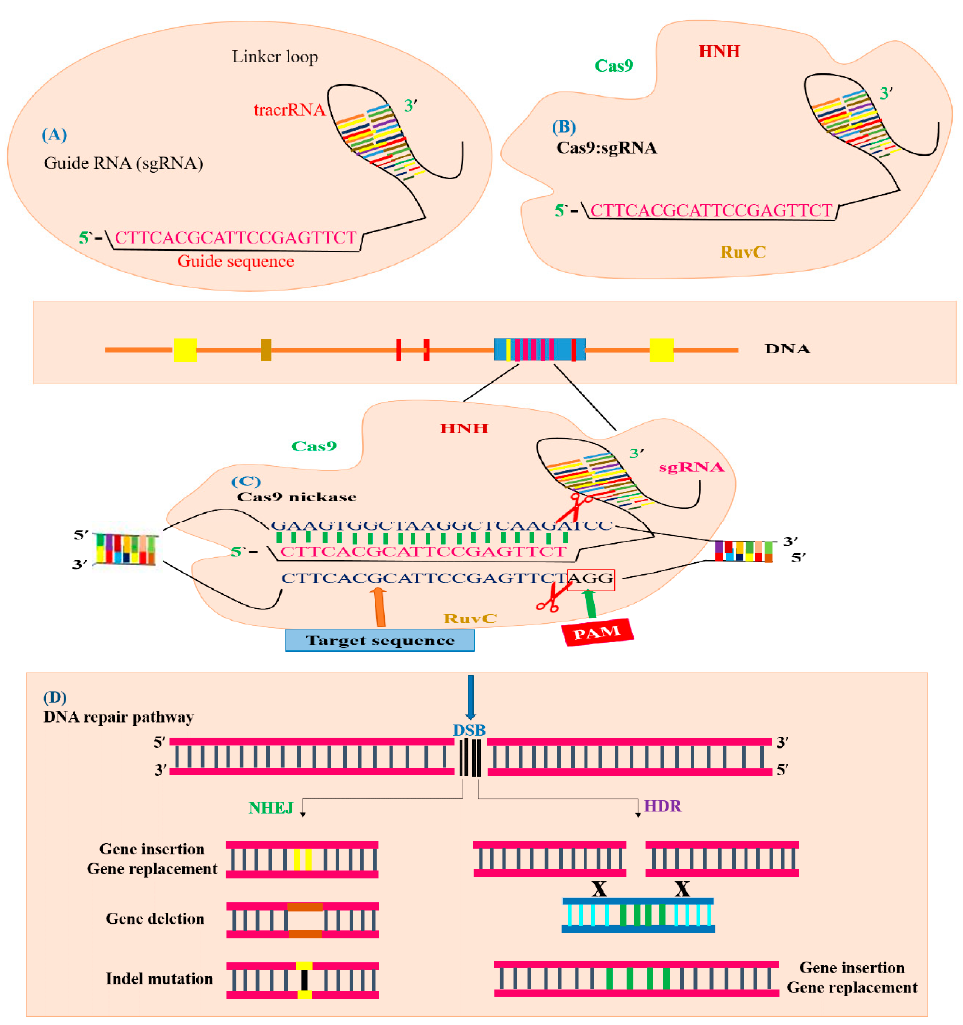
Figure 5. Illustration of CRISPR/Cas9-mediated GE. The CRISPR/Cas9 system is composed of sgRNA and Cas9. ( A ) sgRNA with a guide sequence (colored pink) is developed by the combination of protospacer with crRNA and tracrRNA. ( B ) Cas9 machinery combines with sgRNA to form a complex to trigger CRISPR/Cas9 editing. The Cas9 nuclease consists of two parts, depending on its function and structure. The recognition site identifies the target DNA and interacts with sgRNA. The nuclease site contains two domains RuvC-like and HNH which cleave the target DNA site non-complementary by the RuvC domain and complementary by the HNH domain to the gRNA. ( C ) The Cas9 nuclease detects the genomic target site (indicated with blue color) having a 20 bp target sequence that is homologous to seed or guide sequence (indicated with pink color), which is crucial for Cas9 activity and specificity. The specific PAM sequence (indicated with red color) is detected by Cas9: sgRNA complex and DSBs created by the Cas9 endonuclease three base pairs upstream of the PAM sequence. ( D ) Targeted mutagenesis of a desired gene is achieved by filling the DSB (indicated with black color) by means of the HDR or NHEJ mechanism. The NHEJ repair mechanism generally produces insertion (indicated with yellow color), deletion (indicated with brown color) or indels (indicated with black line) at the break point, generating targeted mutants. The HDR repair mechanism uses a template DNA sequence for homologous recombination to produce gene replacement or gene insertion (indicated with green color).